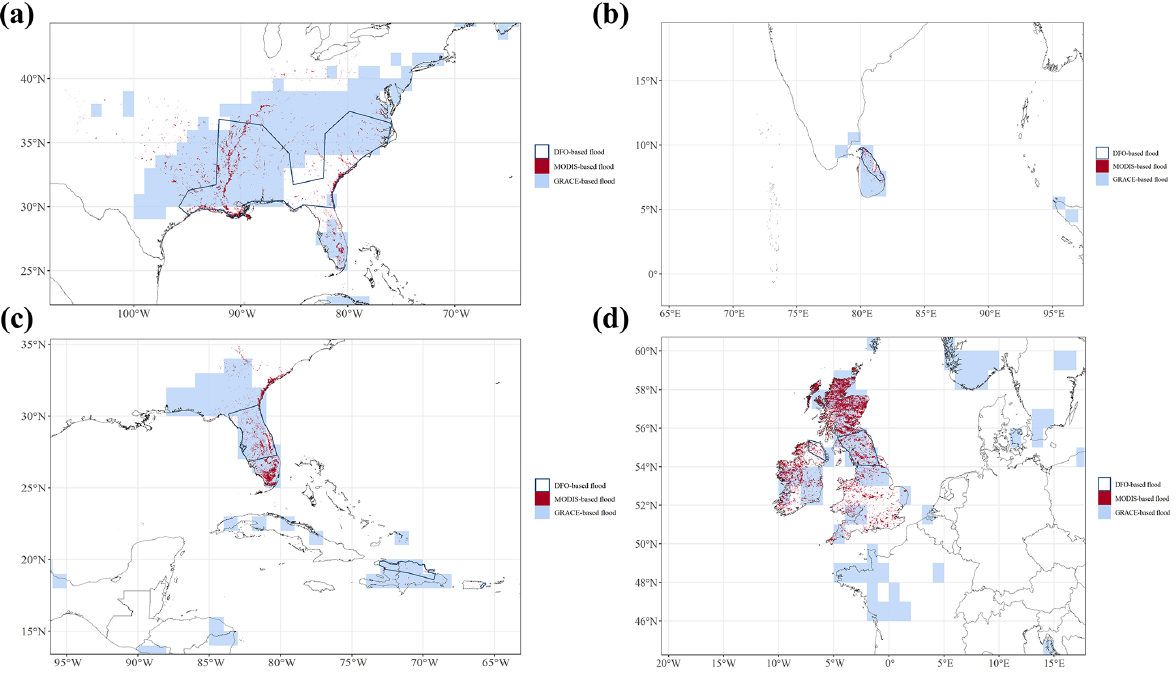
Figure 10. Flood inundation information recorded by the DFO (dark blue polygon), MODIS (red pixels) and GRACE (light blue) showing (a) the ID-2167 flood event that occurred from 22 February to 17 March 2003, (b) the ID-2601 flood event that occurred from 11 to 23 December 2004, (c) the ID-2566 flood event that occurred from 15 September to 1 October 2004 and (d) the ID-4319 flood event that occurred from 5 December 2015 to 26 January 2016. Table 1. Flood detection performance compared with DFO, MODIS and discharge data. DFO (no. of MODIS (no. of Discharge (no. of Discharge (no. of flood events) flood events) flood events) river basins) Total 2380 807 10472 261 Detection 1917 703 5597 156 (POD ≥ 0.5) Percent 81% 87% 53%